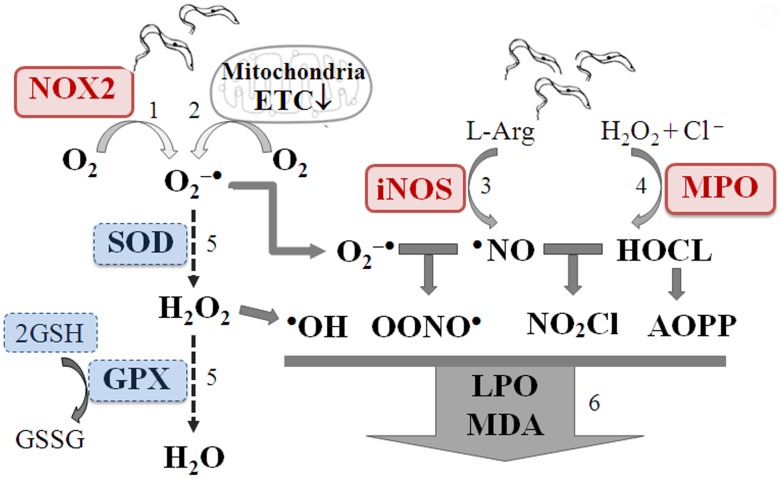
Inter-linked innate immune responses and oxidant/antioxidant status are major determinants of chronic Chagas disease.
Trypanosoma cruzi or danger-associated molecular patterns (DAMPs) released due to cellular injuries stimulate ROS (O2
−•, H2O2, •OH) production by (1) NADPH oxidase–dependent oxidative burst in macrophages/monocytes and (2) mitochondrial membrane permeability transition and electron transport chain (ETC) inefficiency in non-phagocytes (e.g. cardiac myocytes). Likewise, Tc and DAMPs can activate phagocytes/neutrophils resulting in (3) iNOS-dependent •NO and (4) myeloperoxidase-dependent HOCl production. If these reactive species are not scavenged by (5) activation of antioxidants (e.g. superoxide dismutases (SOD), glutathione peroxidase (GPX) and glutathione (GSH), then highly stable free radicals, e.g., peroxynitrite (•OONO), nitrosyl chloride and AOPPs are formed that (6) further inflict host cellular oxidative damage of lipids (e.g. LPO, MDA). The intracellular molecules (e.g., DNA, protein, lipids) that may be released from apoptotic or necrotic cells in oxidized form serve as DAMPs, sustaining the signaling activation of innate immune cells in chronically infected chagasic subjects.